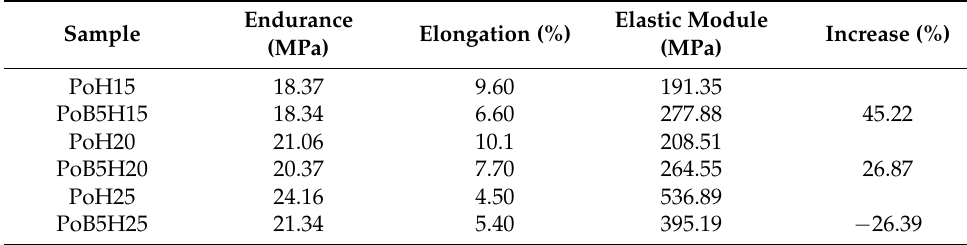
Table 4. Experimental results.